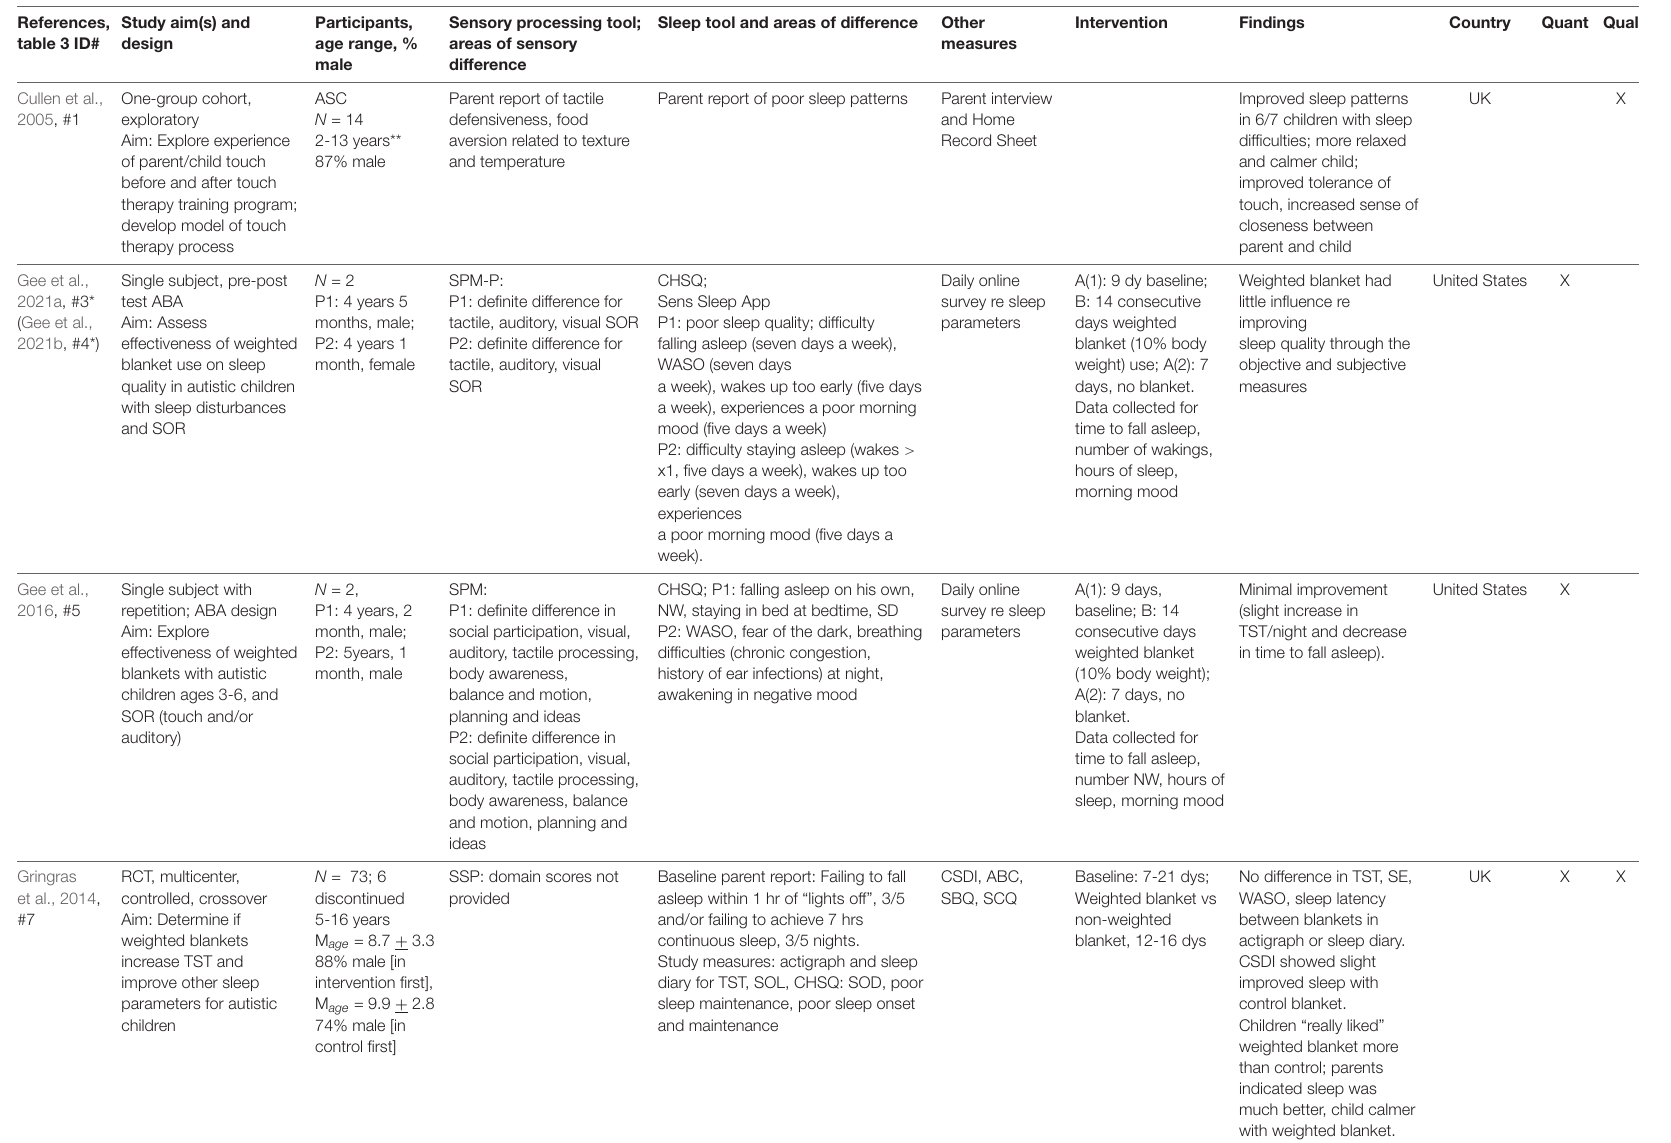
TABLE 3 | Interventions addressing sleep and sensory processing. References, Study aim(s) and table 3 ID#